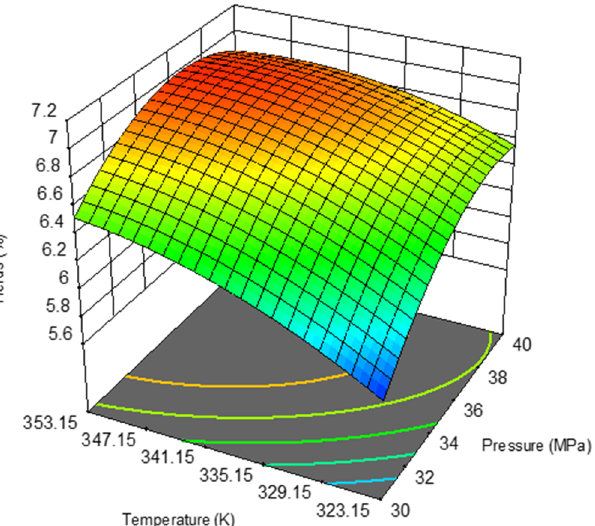
Figure 3. Response surface plot showing the effects of the temperature and pressure on the rice oil bran extraction yield.